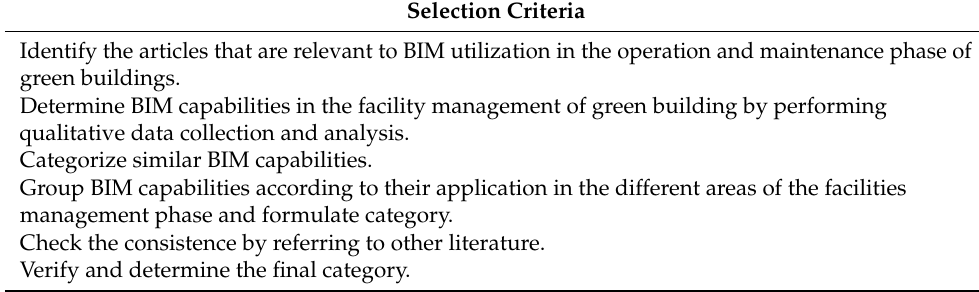
Table 3. Selection criteria for developing categories [20].